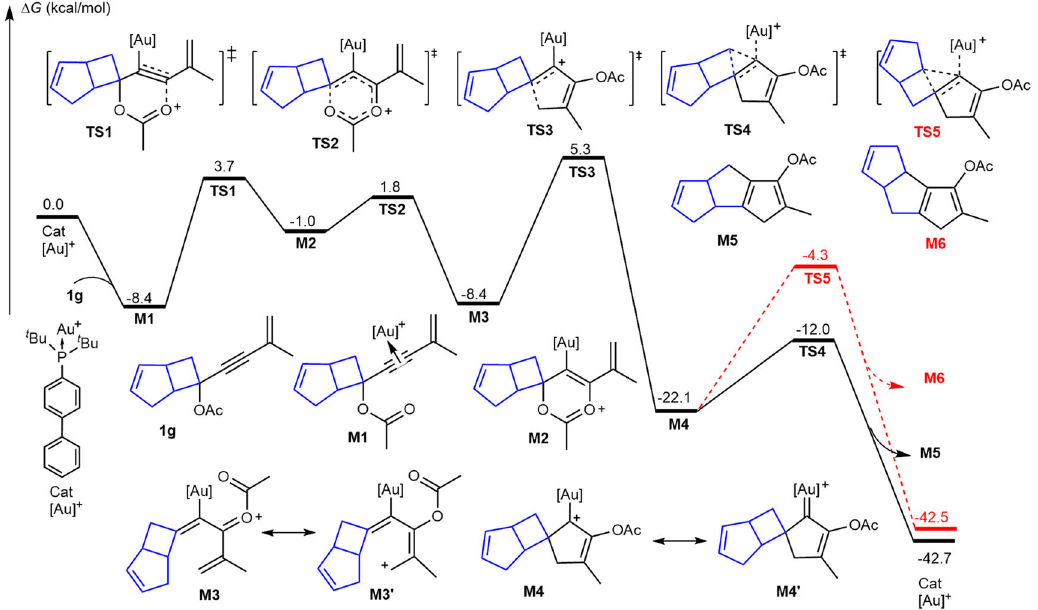
Fig.7|Calculatedfreeenergypro fi lesforthecationicAu(I)catalyzedcyclizationofcyclopentadienylacetate. TherelativefreeenergiesarecomputedattheM06-L/ def2-TZVPP/SMD dichloroethane //M06-L/def2-SVP/SMD dichloroethane level.